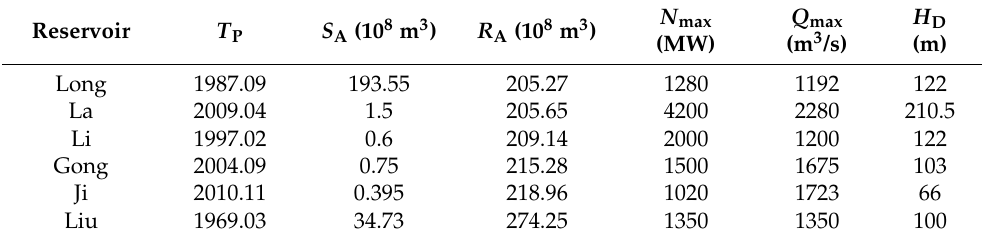
Figure 4. Annual runoff processes of TNH ( a ), GD ( b ), XH ( c ), and XC ( d ) stations at the UYR (Note: the number in the box denotes the multiyear average runoff volume.). Table 2. Basic information of the UYR multireservoir system.